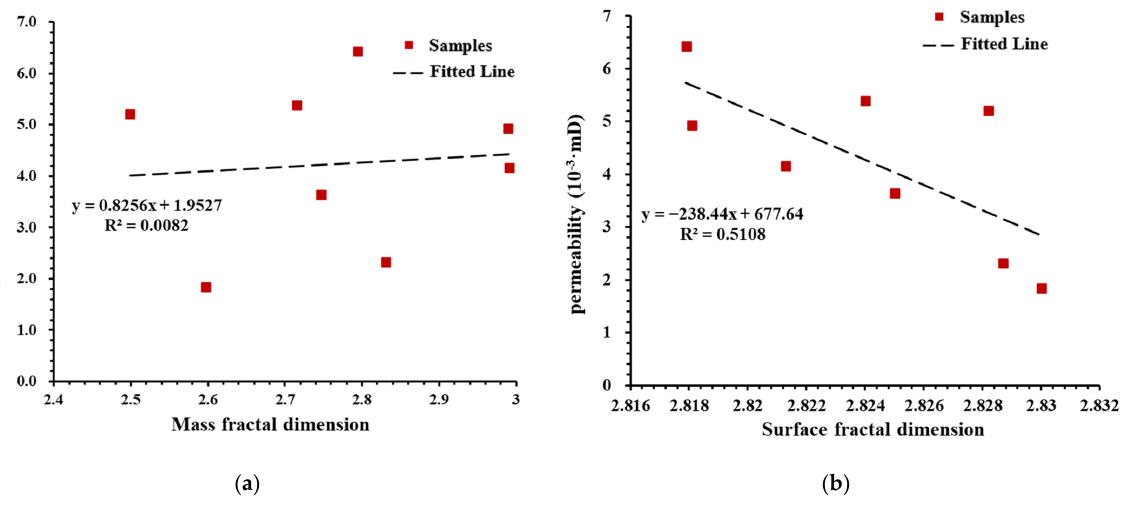
Figure 15. ( a ) Relationship between the mass fractal dimension of the deep shale samples and per ‐ meability. ( b ) Relationship between the surface fractal dimension and permeability of the deep shale samples.